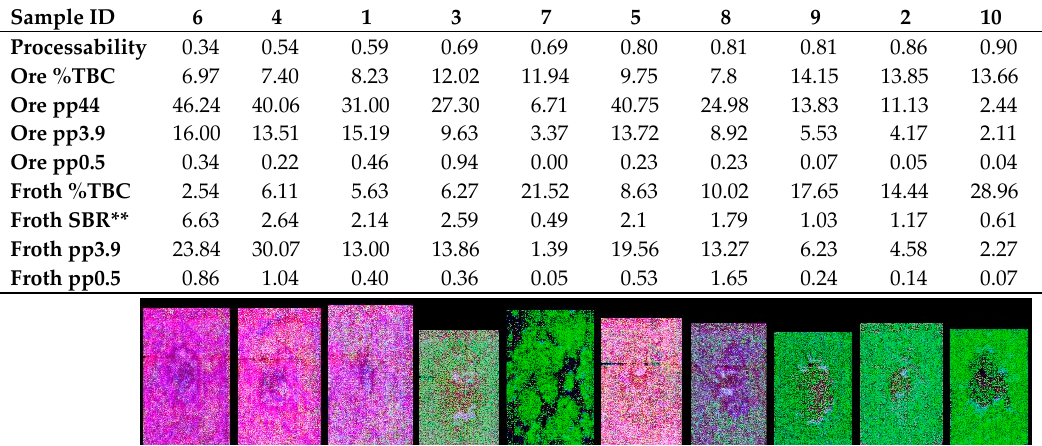
* Color composite of froth hyperspectral imagery in continuum removed reflectance (red = 1750 nm, green = 2205 nm, blue = 2350 nm). ** SBR = solids to bitumen ratio. All the pp values are percent passing at the given size measured in